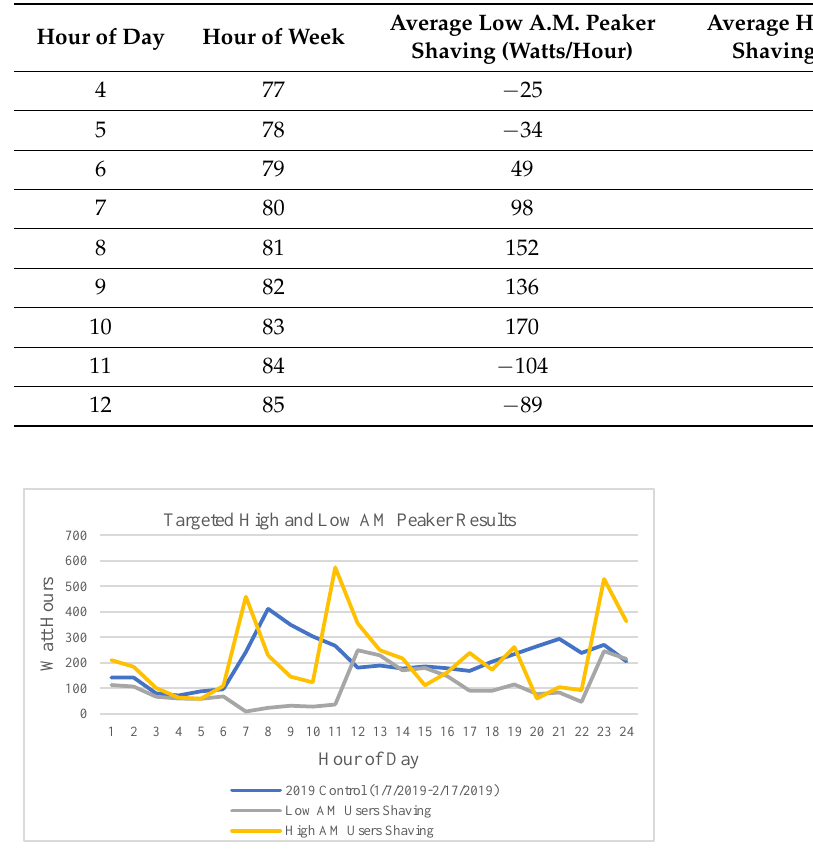
Table 6. Example Results from Targeted Group Strategy.